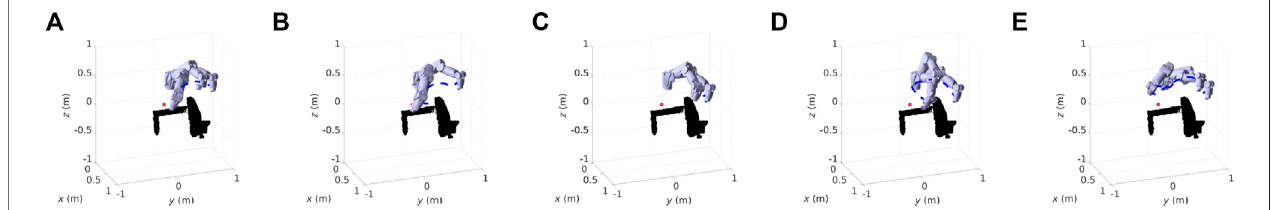
FIGURE 11 | The motion of the Baxter arm in a real scenario with environment consisting of black chair and table (drawn in black) using (A) the MFI algorithm with geometric control, (B) the MFI algorithm with PD control, (C) standard APF method, (D) CF method and (E) GF method, respectively. The dashed lines are the tip ’ s